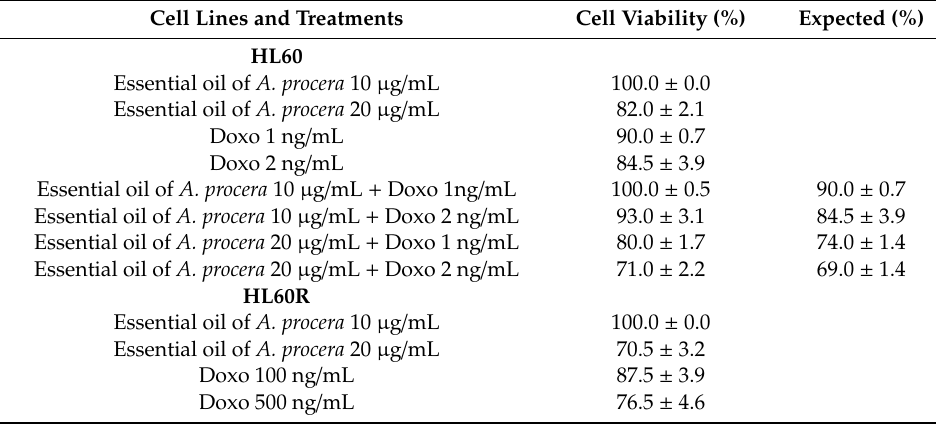
Figure 3. Cytotoxic activity of A. procera essential oil on HL60 ( A ) and HL60 R ( B ) cell lines. Cell viability was assessed by MTS. Data are expressed as mean ± standard error (SE) of at least three di ff erent experiments performed in triplicate. Di ff erent letters represent significant di ff erences in cytotoxic activity among the concentrations of each cell line (Tukey test, p < 0.05). Table 2. Cell growth inhibition in HL60 and its multidrug resistant variant HL60R following treatment with essential oil of A. procera and doxorubicin (Doxo) or a combination of